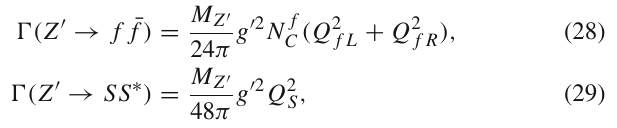
Fig. 8 Branching ratios of scalar singlet H 1 for sin α = 0 . 1 (left) and sin α = 0 . 02 (right). In this figures, we have also fix M N v = 10 TeV. Note in left pattern, BR ( H S